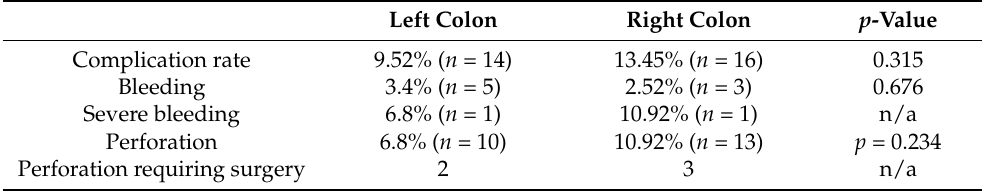
Table 5. Complications regarding the location of lesions in the right or left colon. Left Colon Right Colon p -Value Complication rate 9.52% ( n = 14)